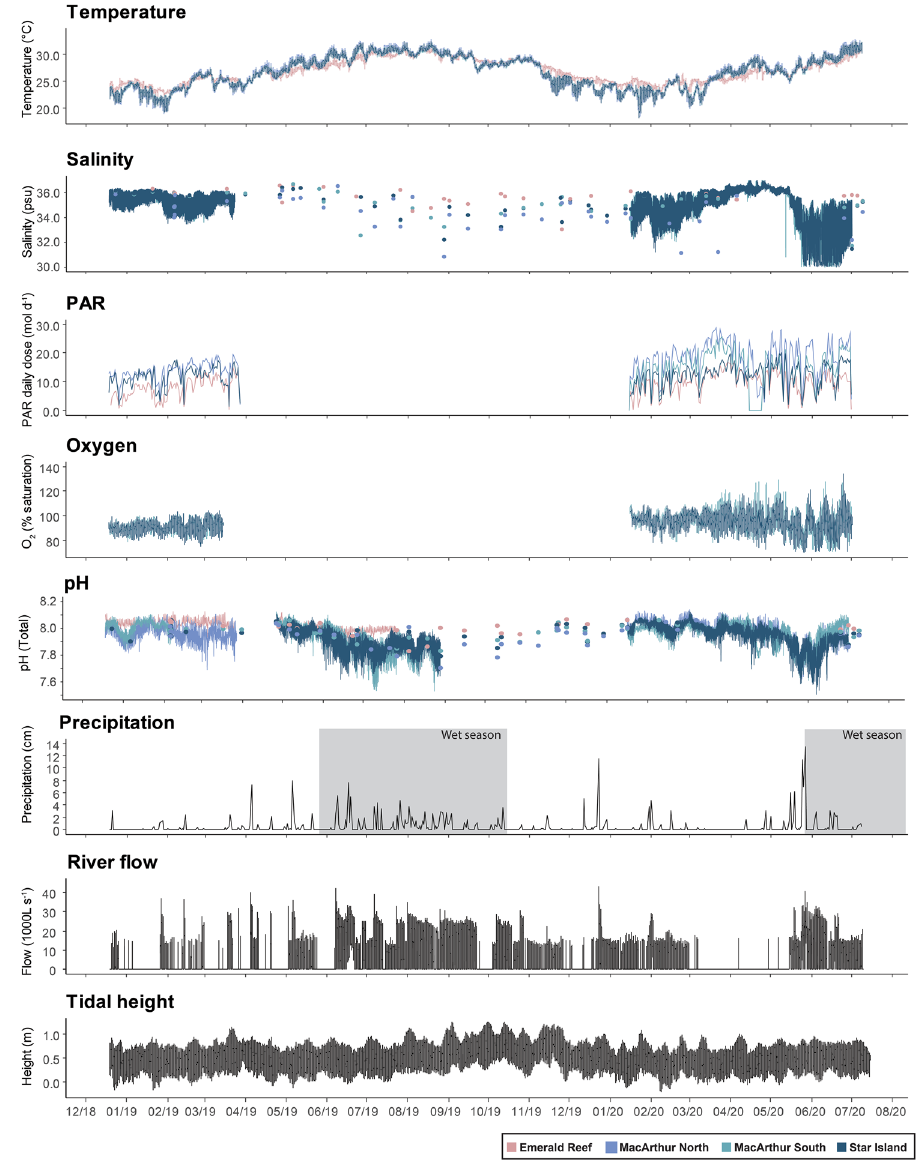
Figure 2. Environmental conditions at a natural coral reef (pink) and three inshore urban sites (blue) over the study’s duration. Continuous data are shown as lines, while discrete samples are shown as points (see salinity and pH data). Precipitation (cm), river flow (1000 L s −1 ) and tidal height (m) are not site-specific and are shown in black. Zeros in river flow may reflect an absence of data, rather than no flow. PAR is photosynthetically active radiation expressed as a daily dose (mol d −1 ). Wet seasons are overlaid on precipitation data in